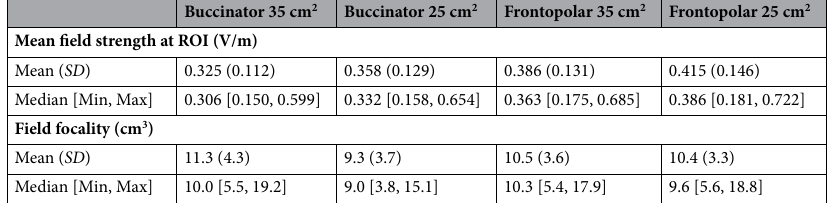
Table 1. Mean field strength at the ROI and field focality for each of the four tested conventional electrode montages.